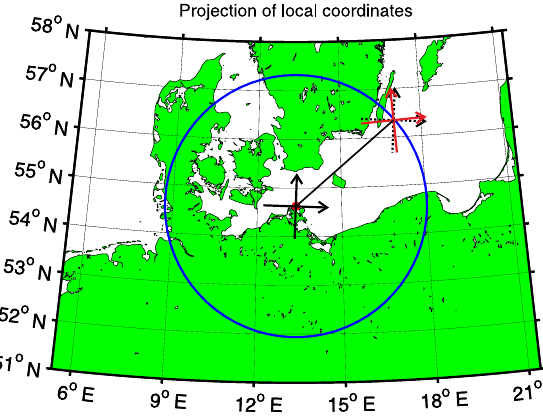
Figure 2. Illustration on how local coordinates (zonal, meridional) change with geographic position with respect to a radar